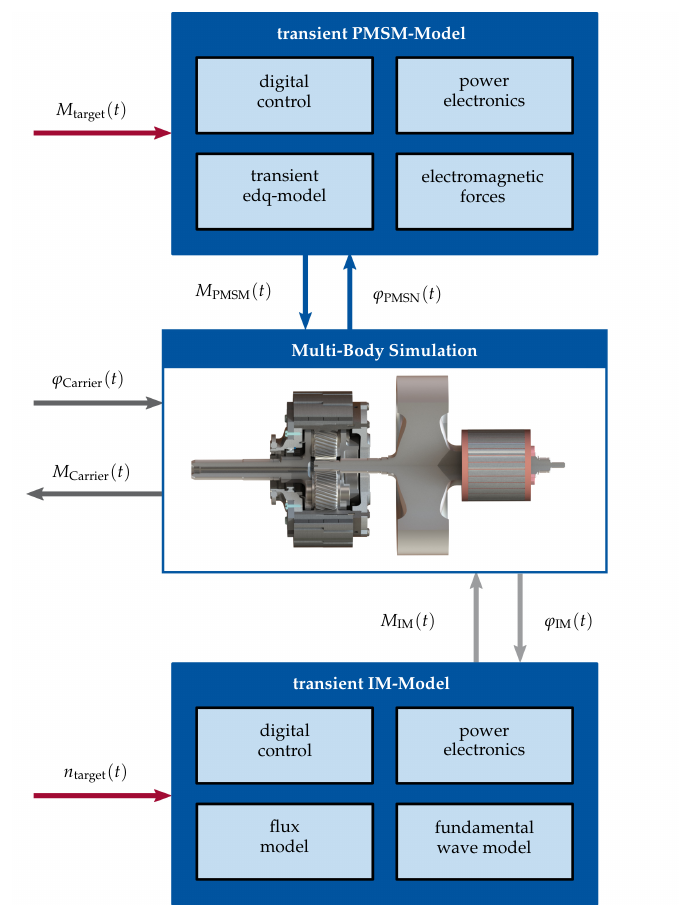
Figure 6. Schematic structure of the proposed system